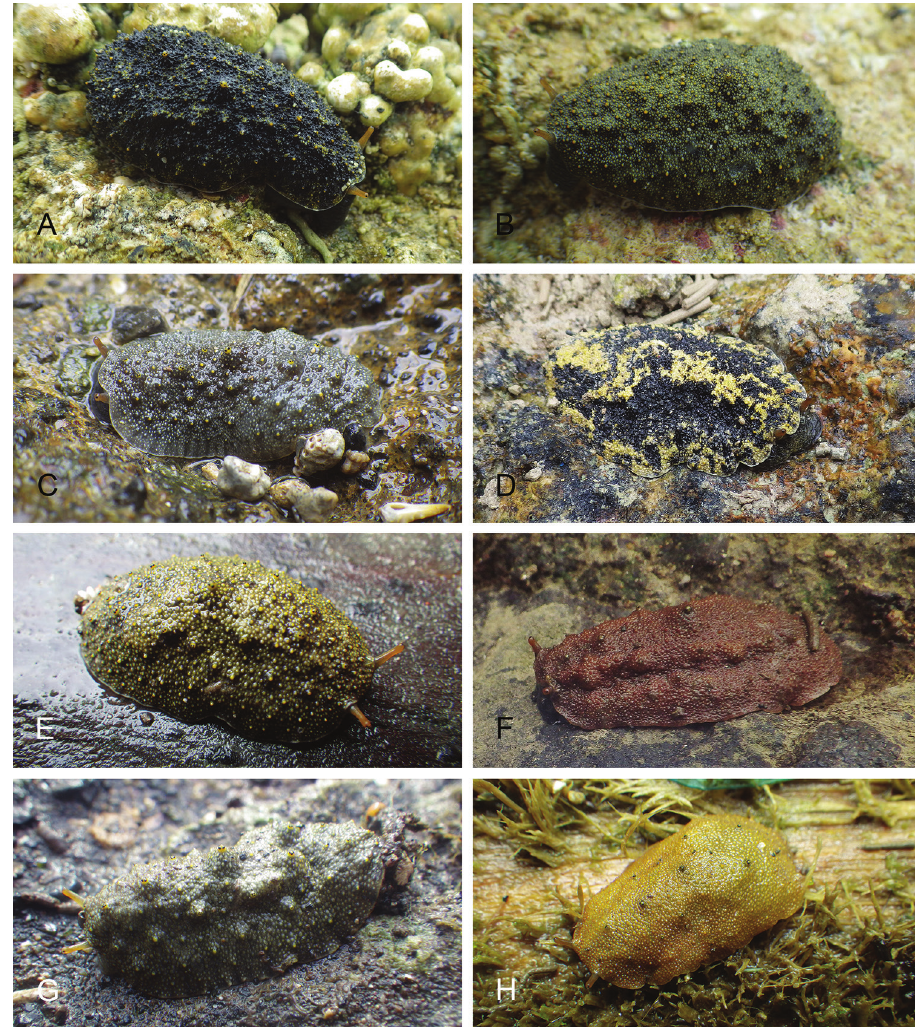
Figure 36. Live specimens, dorsal view, Wallaconchis ater . A 33 mm long [3265], Philippines, Bohol (PNM 041214) B Dorsal view, 34 mm long [3271], Philippines, Bohol (PNM 041222) C 26 mm long [3210], Philippines, Luzon (PNM 041213) D 26 mm long [3405], Philippines, Bohol (PNM 041219) E 26 mm long [2164], Indonesia, Sulawesi (UMIZ 00036) F 38 mm long [5057], Indonesia, Halmahera (UMIZ 00046) G Dorsal view, 22 mm long [3137], Indonesia, Bali (UMIZ 00053) H 25 mm long [2157], Indonesia, Sulawesi (UMIZ